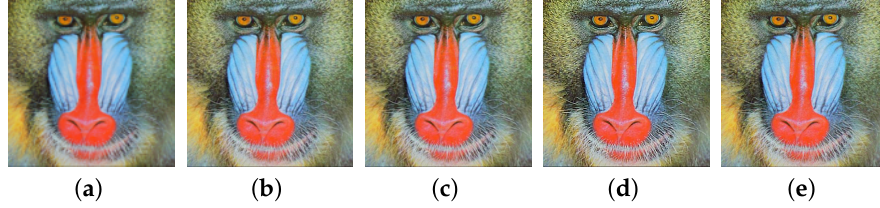
Figure 2. Results of image interpolation. From left to right are: ( a ) original image; ( b ) bi-linear interpolation; ( c ) new edge directed interpolation (NEDI) interpolation; ( d ) fast upsampling interpolation; ( e ) C − 1 interpolation.